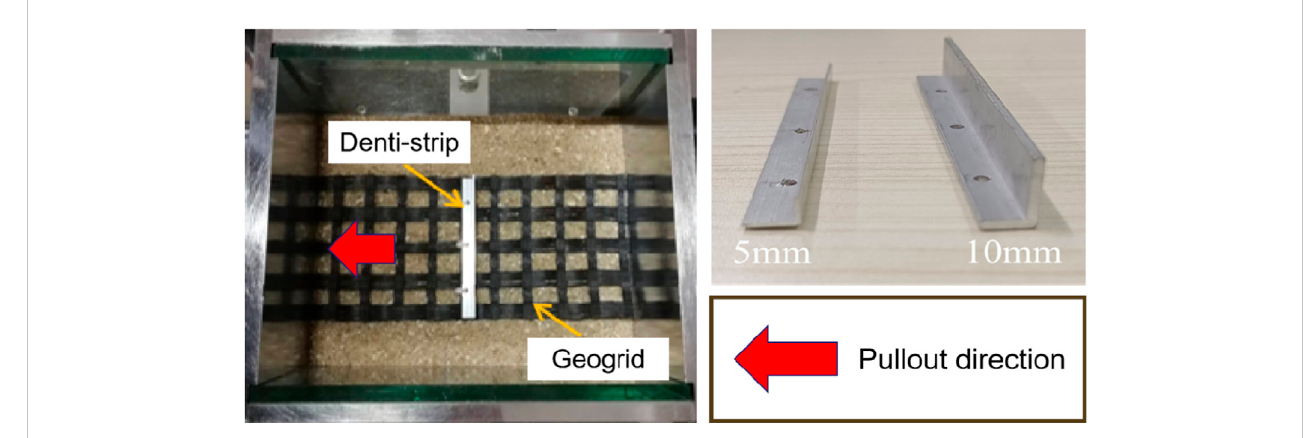
FIGURE 2 Toothed geogrid specimen and location.